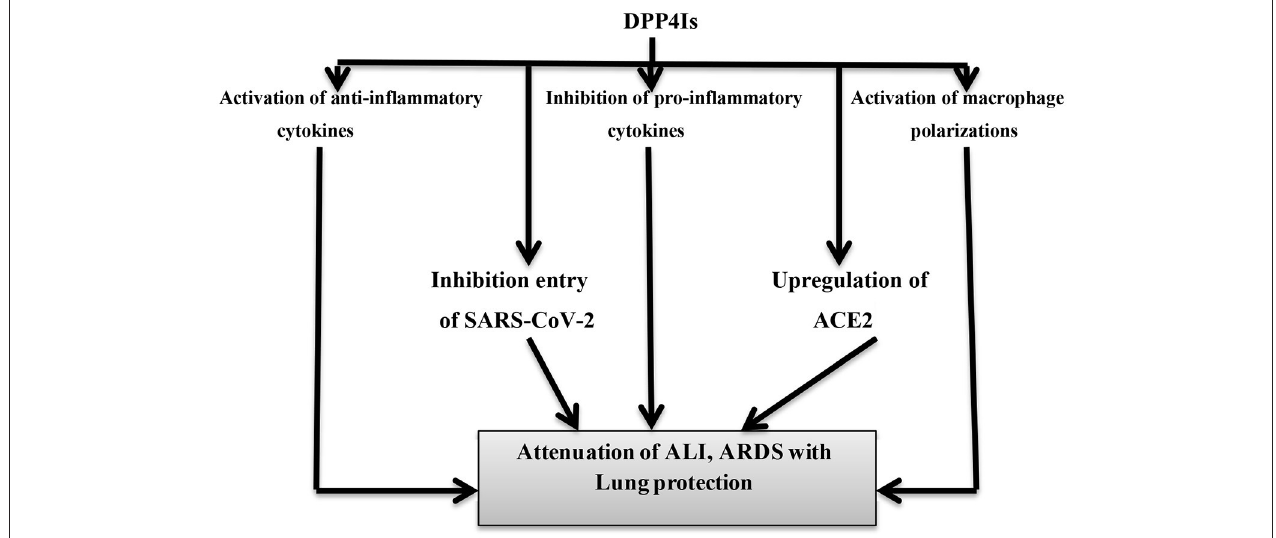
FIGURE 7 | Potential effects of DPP4 inhibitors on the pathogenesis of COVID-19. Dipeptidyl peptidase-4 inhibitors (DPP4Is) have anti-inflammatory effects through the activation of anti-inflammatory cytokines, the activation of macrophage polarizations, and the inhibition of pro-inflammatory cytokines. DPP4Is inhibit the entry of SARS-CoV-2 through blocking of DPP4 receptors. The net effects of DPP4Is are lung protection with improvement in acute lung injury (ALI) and acute respiratory distress syndrome